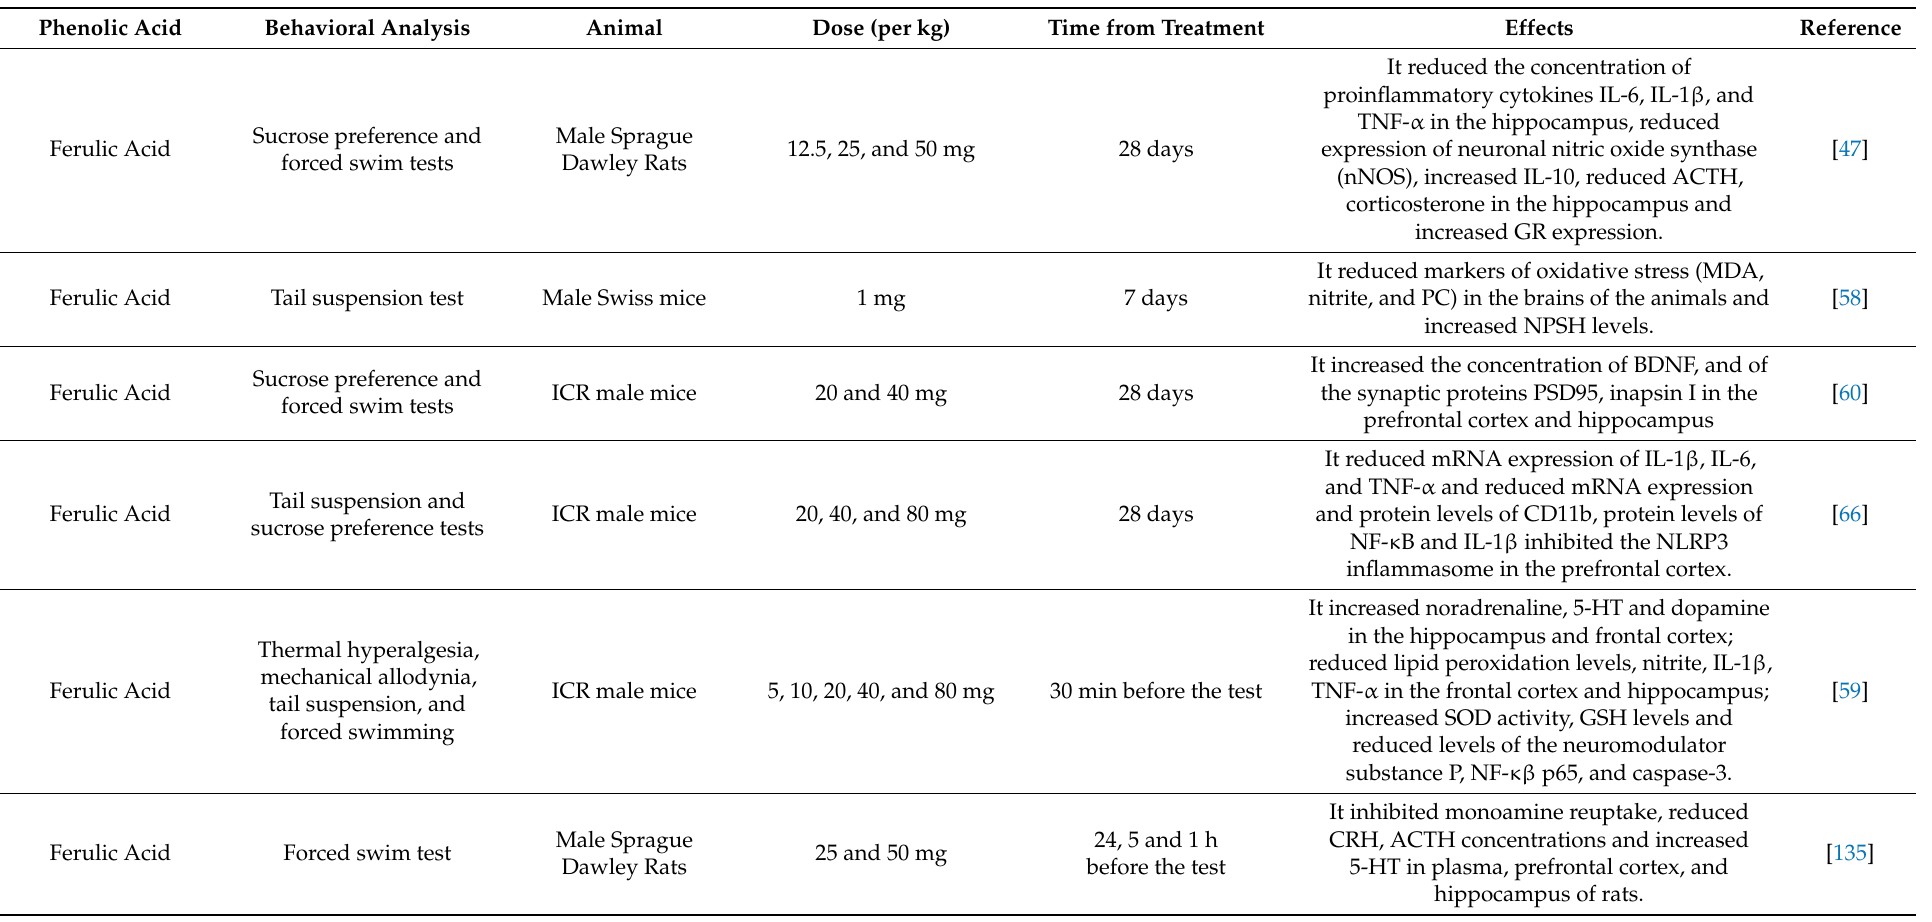
Table 1. Effect of phenolic acids on animal models of depression and their mechanisms of